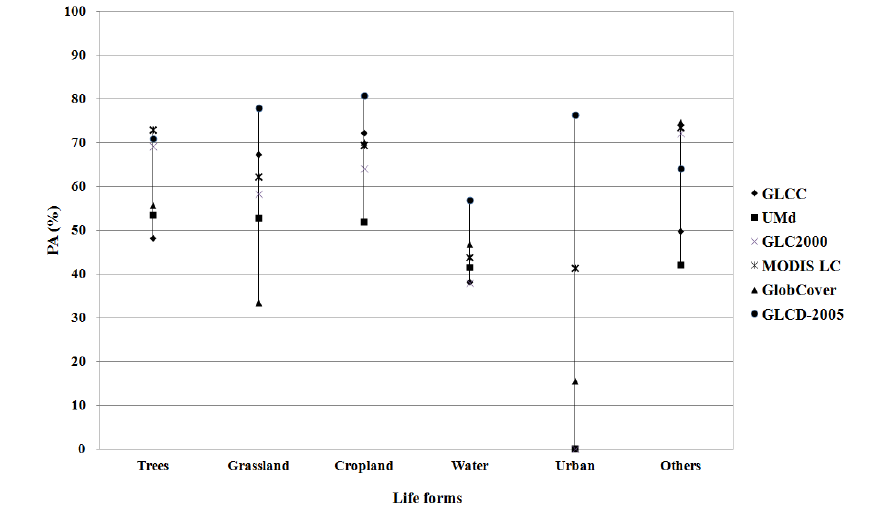
Figure 5. Producer’s accuracy of the six land cover maps with life forms in